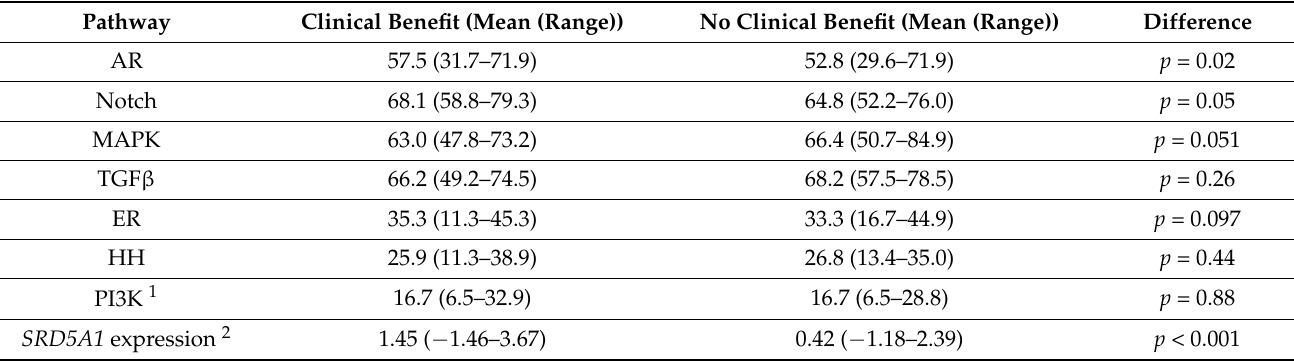
Figure 1. Violin plots of pathway activity scores ( A ) and dot/box-plot for SRD5A1 expression ( B ) for the patients with (blue) and without (orange) clinical benefit. Dotted lines in (A): quartiles. * = p < 0.05, *** = p < 0.001. Table 2. Pathway activity score differences between patients with and without clinical